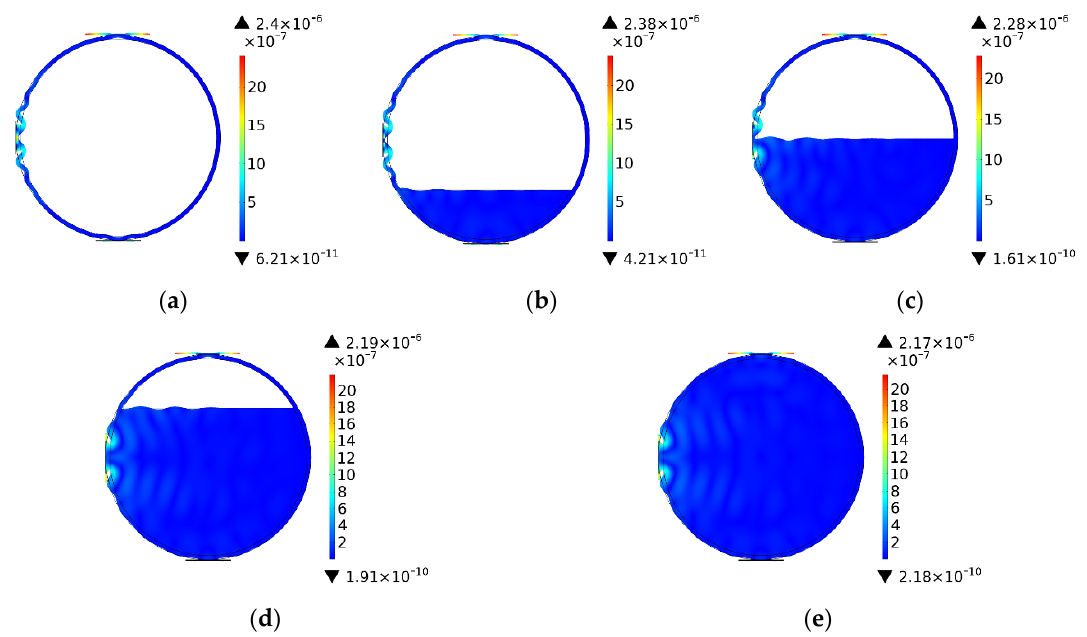
Figure 14. The structural deformation excited by PZT patches at frequency P2 (unit: mm). ( a ) Empty;